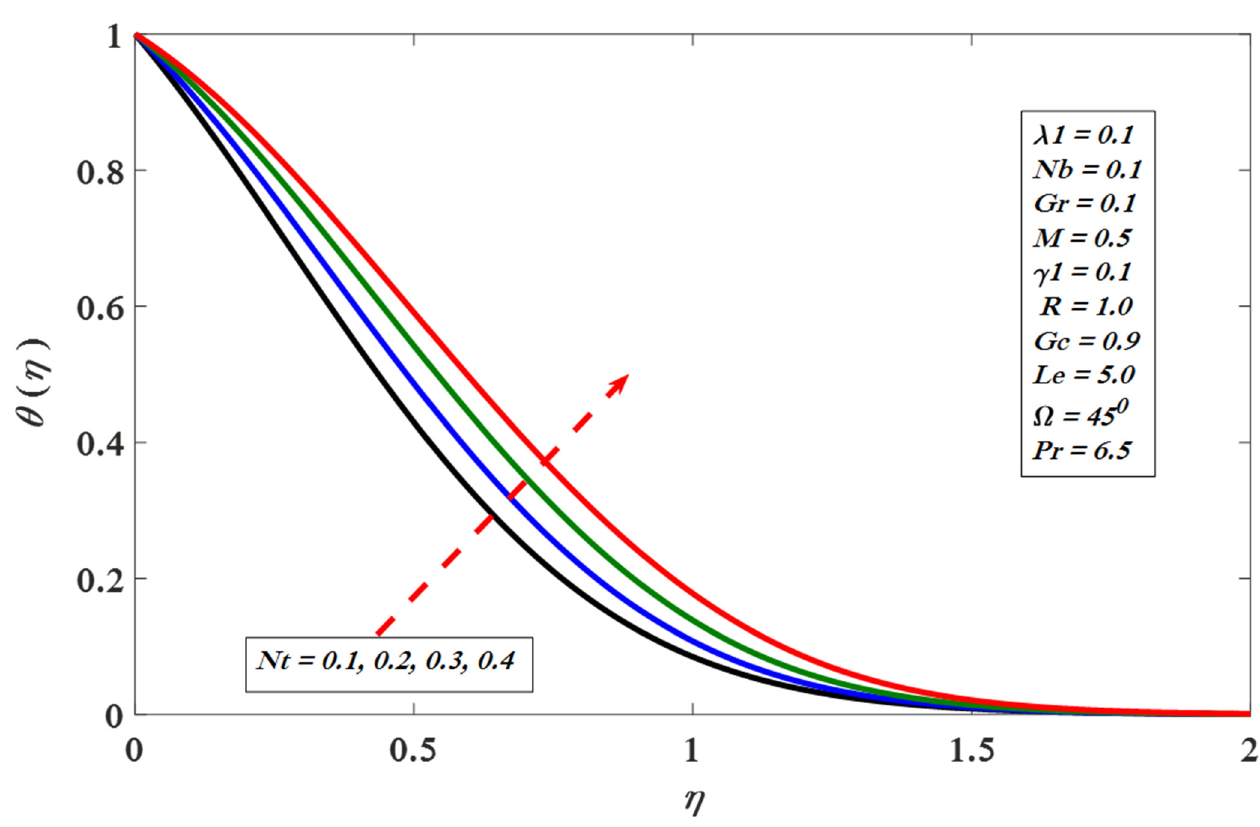
Figure 11. Temperature profile versus Nt .